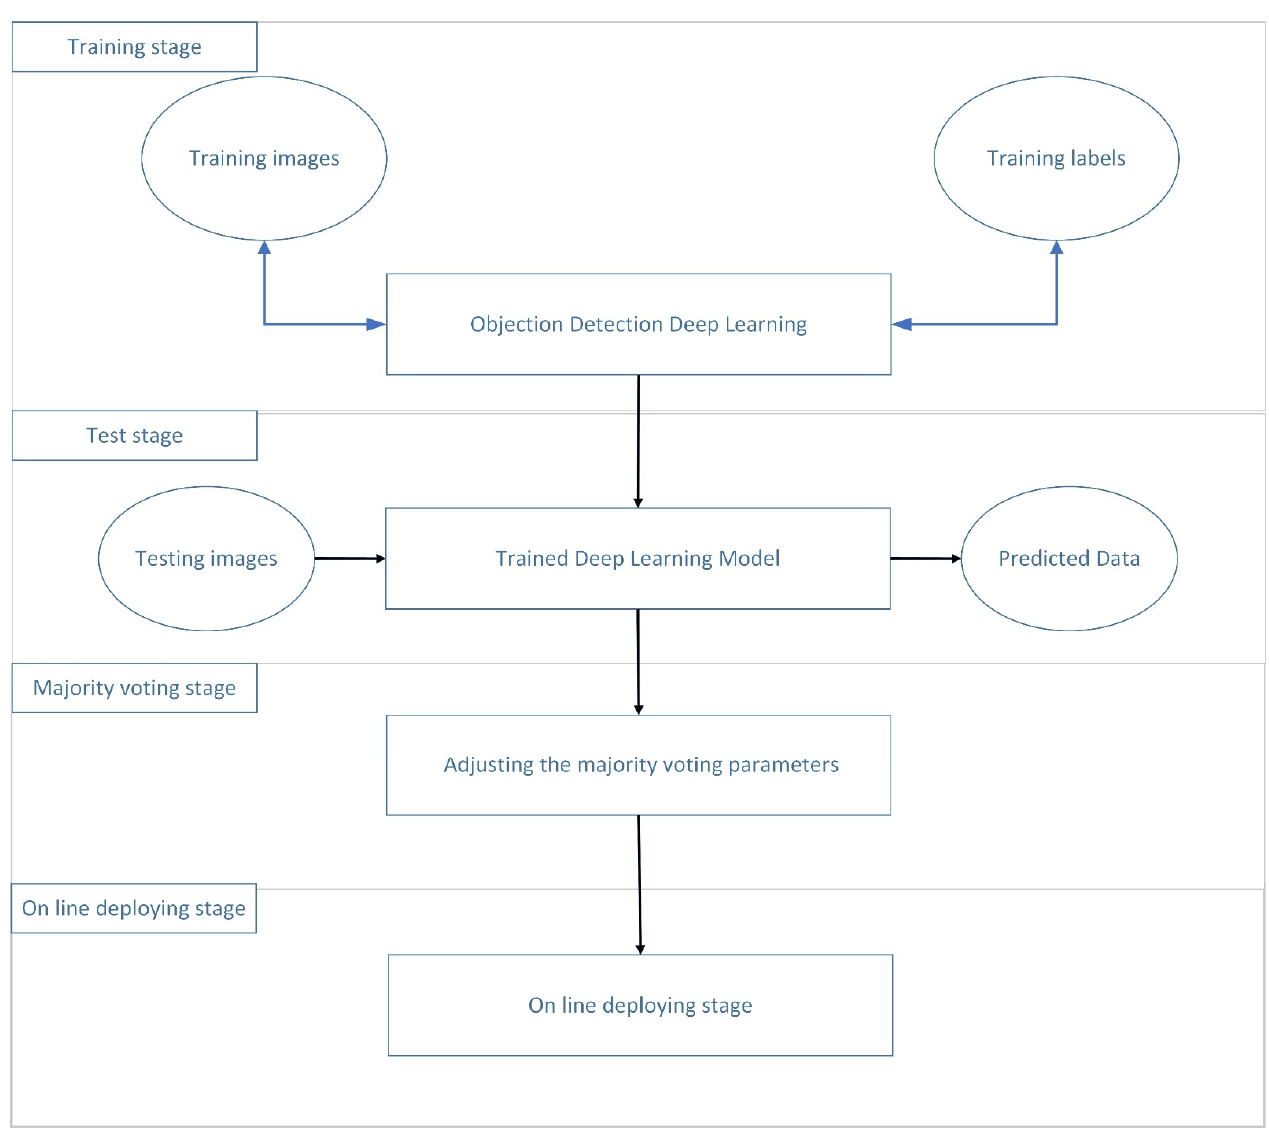
Figure 4. Operation process of Yolo-based feature extraction and majority voting integrated system construction process.